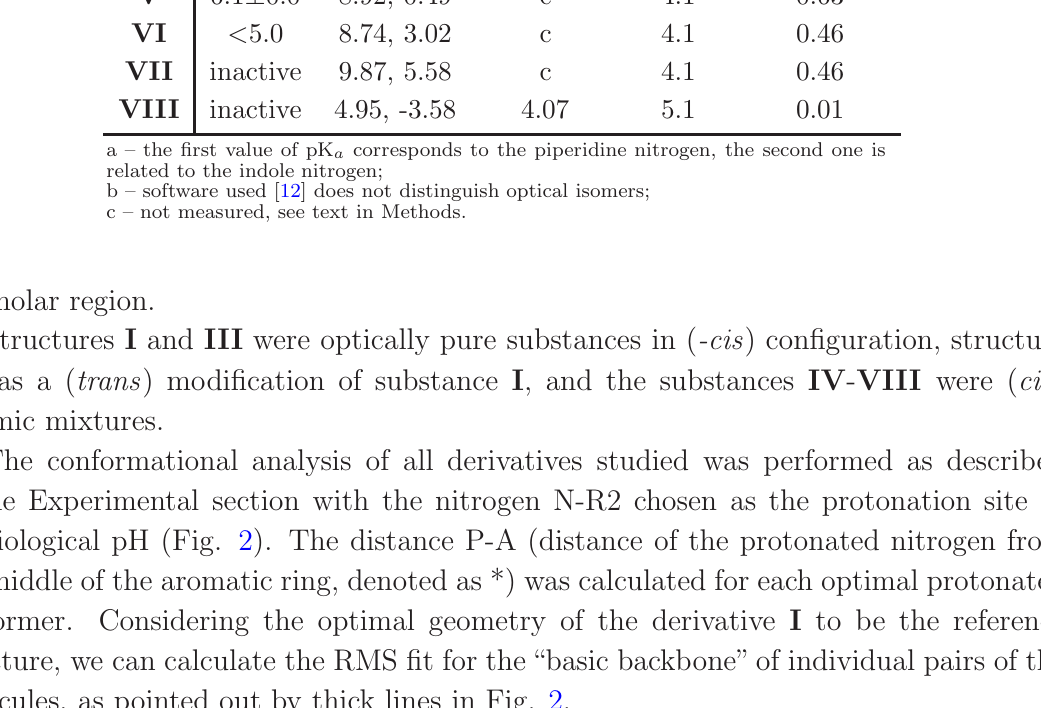
activities (pA ), ionization constants pK 1 A 2